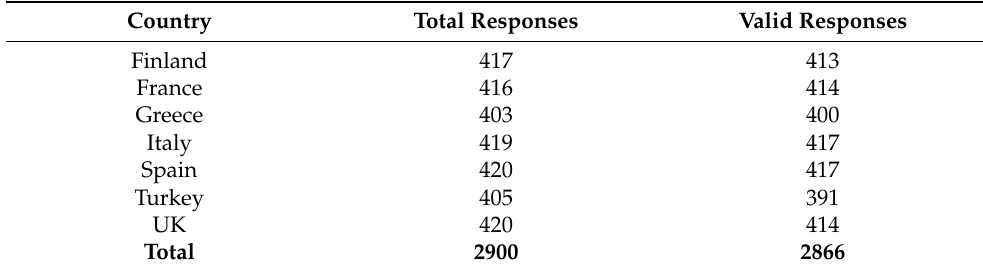
Table 2. Collected responses per country.